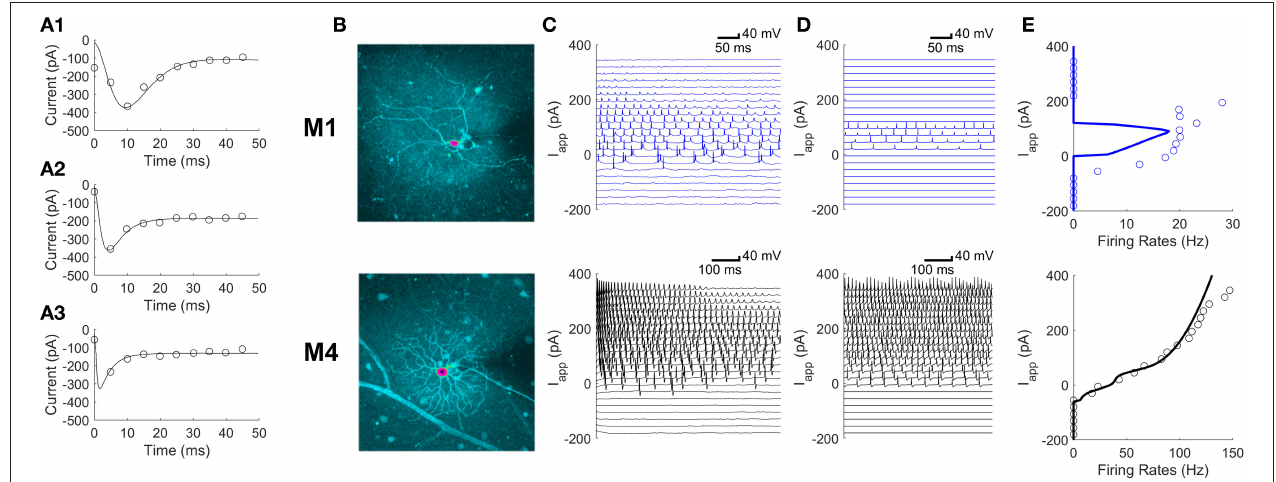
FIGURE 1 | Differences in parameters of ionic currents can explain differences in firing patterns between M1 and M4 ipRGCs. (A1–A3) Voltage clamp Ca 2 + currents averaged over 5ms (circles) in a single M1 cell in response to depolarizing voltage steps of 30, 60, and 90mV in amplitude for panels (A1–A3) , respectively. Fits of this kind were used to develop the model. (B) The intracellular dye fills of an M1 ipRGC (top) and an M4 ipRGC (bottom); pink centers mark the somas. (C,D) A model validation comparing experimental current-clamp data (C) to simulated data (D) in M1 cells (top) and M4 cells (bottom) at varying levels of the applied current, I app . (E) Comparing model (solid curve) and experimental (circles) firing rates in M1 cells (top) and M4 cells (bottom) at varying levels of I app . The firing rates were estimated from the current clamp responses in panels (C) and (D) .